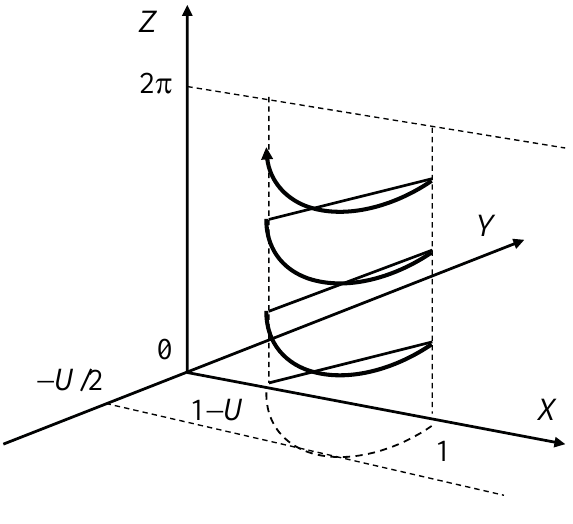
Fig. 2. Sketch of an orbit in the state space of the spring-block system with variable driver velocity, under the assumptions A ≈ 0 and V ≈